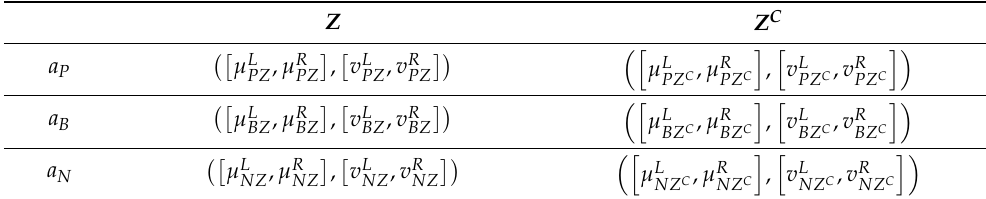
Table 2. Risk loss